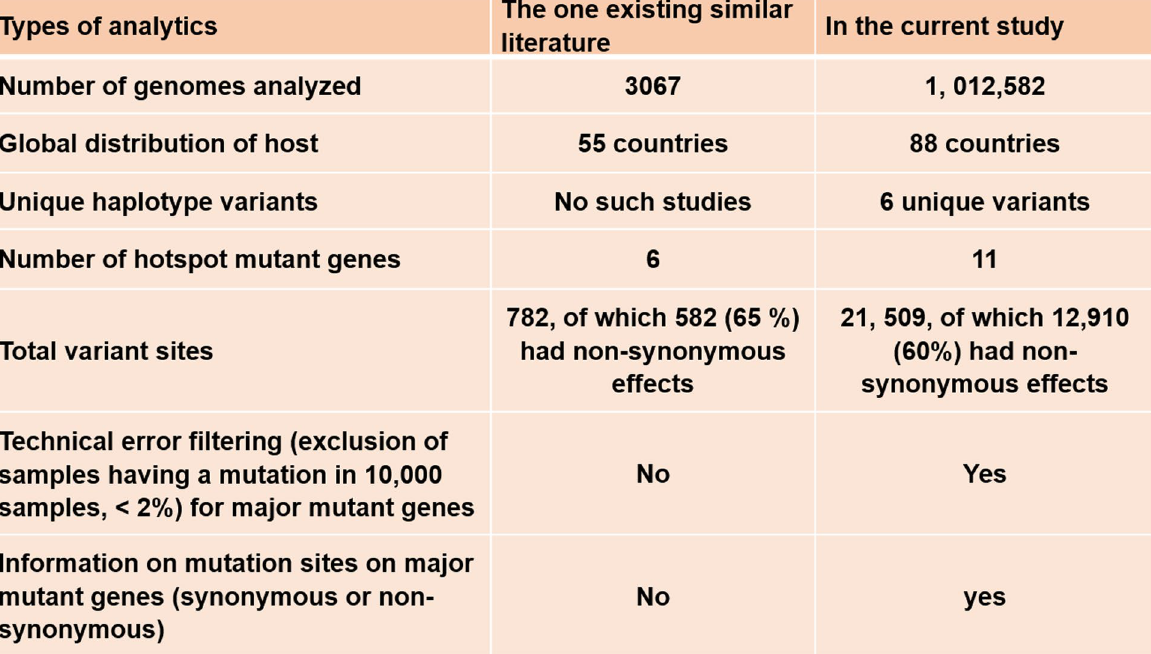
Table 4 Comparison of analytics of the present study with the existing similar literature. A comparison of analytics was made representing the global sample volume, distribution, unique variants, major mutant genes, variant sites, and filtering